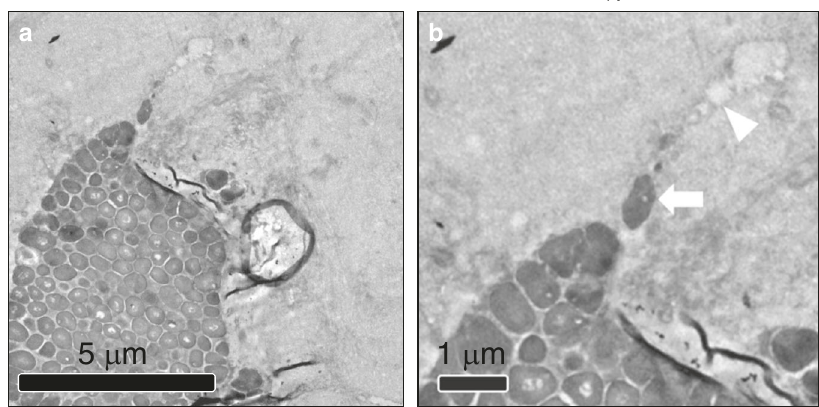
Fig. 6 Transmission electron microscopy in native mouse femur. a Low power (×8 000) TEM images of Xen36 S. aureus invasion of the Haversian canal and adjacent canaliculus of cortical bone. b Enhancement of region of interest shows canaliculus (white arrowhead) with elongated S. aureus (white arrow) at con fl uence of canaliculus and Haversian canal. The discovery of elongated S. aureus at the con fl uence of the haversian canal and canaliculi supports the hypothesis that this process occurs in cortical bone in both allograft and native bone, representing a potential mechanism by which the cocci bacteria evade the host immune